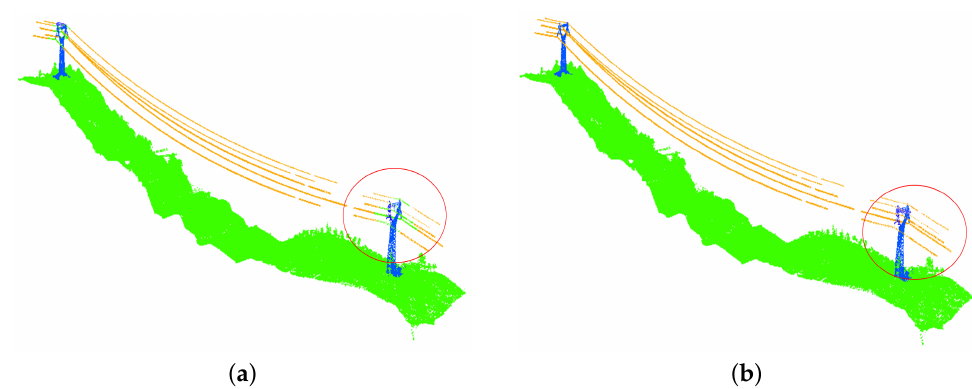
Figure 16. ( a ) The coarse extraction result in sparse points area. ( b ) The results after the spatial line clustering and power line